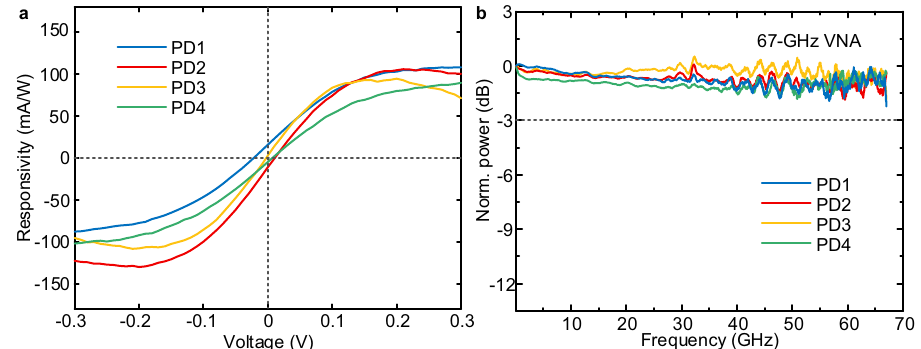
Fig. 3 The performances of graphene-on-PSW PDs. a The responsivity as a function of the bias voltage for the four PDs at 1550 nm. b Frequency responses of the four PDs. VNA: vector network analyzer.